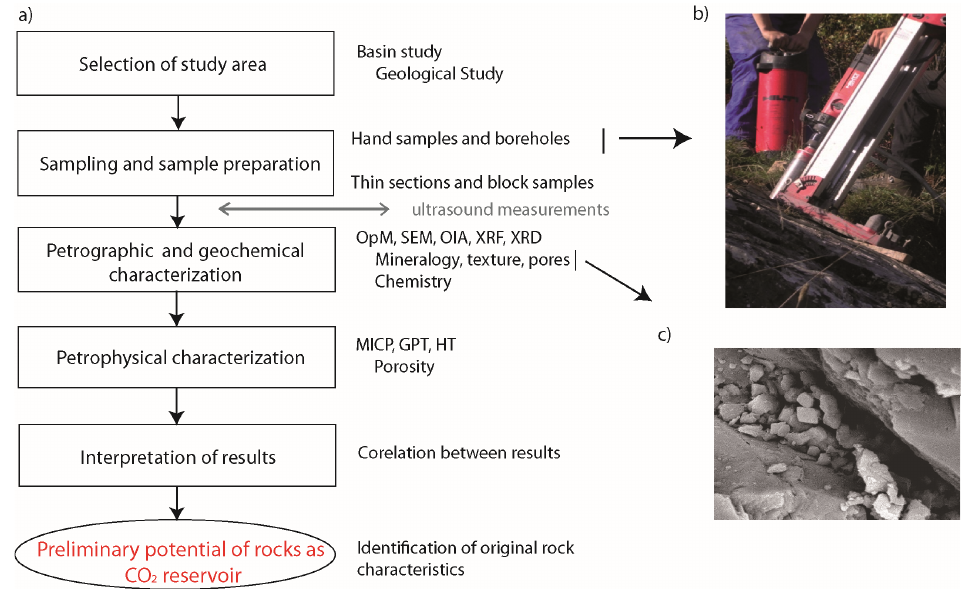
Figure 2. ( a ) Schematic representation of the work sequence followed in this study; ( b ) sampling; ( c ) SEM image of the studied sandstones.